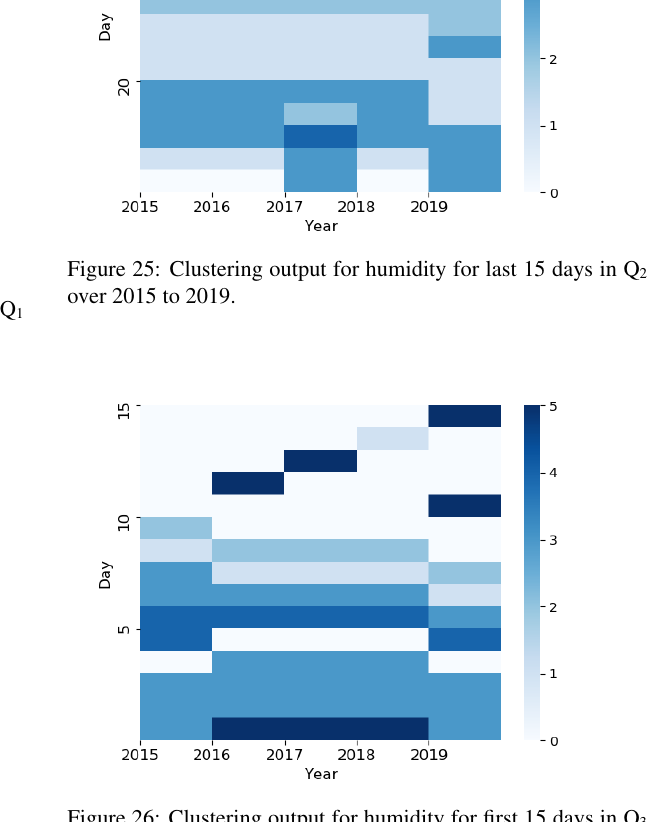
Figure 26: Clustering output for humidity for first 15 days in Q 3 over 2015 to 2019.